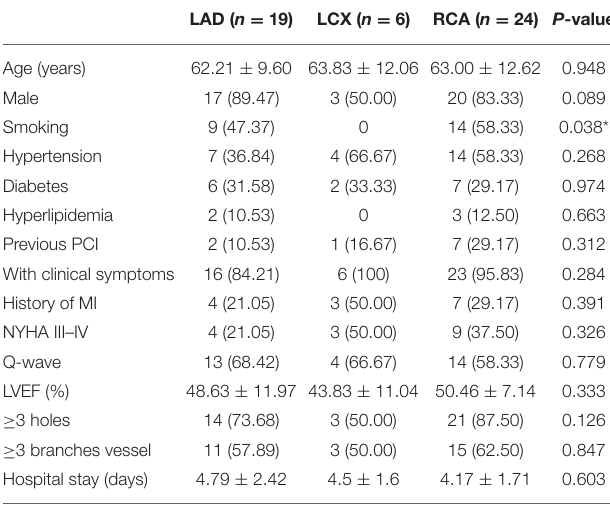
patients. Among them, ACFs were found in 49 (2.66%) TABLE 3 | Clinical and angiographic characteristics of three CTO vessel